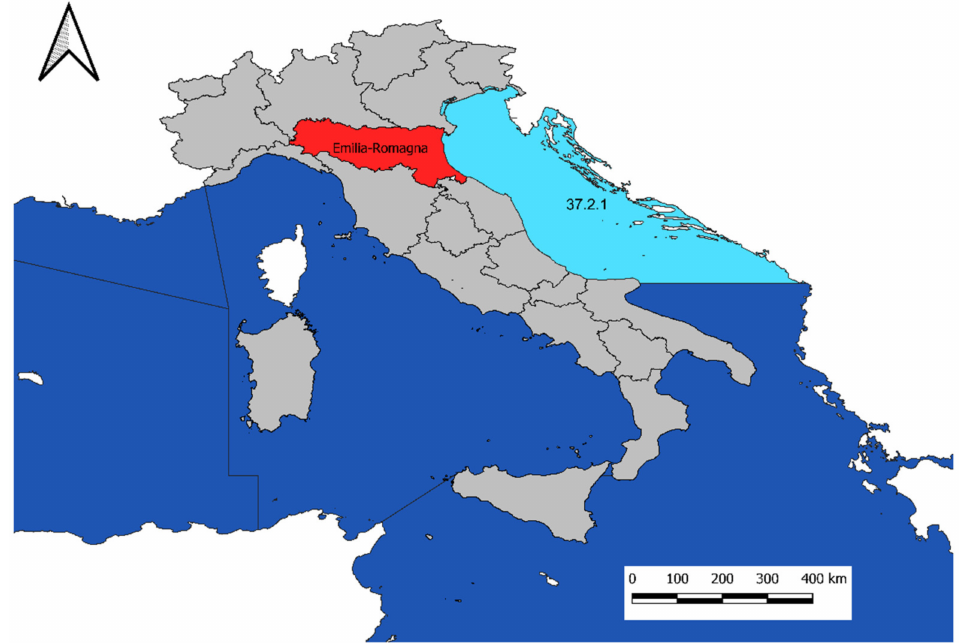
Figure 1. Sampling area along the Emilia-Romagna region coast, Northern Italy (red) Adriatic Sea (blue), FAO zone 37.2.1, GSA 17 (light